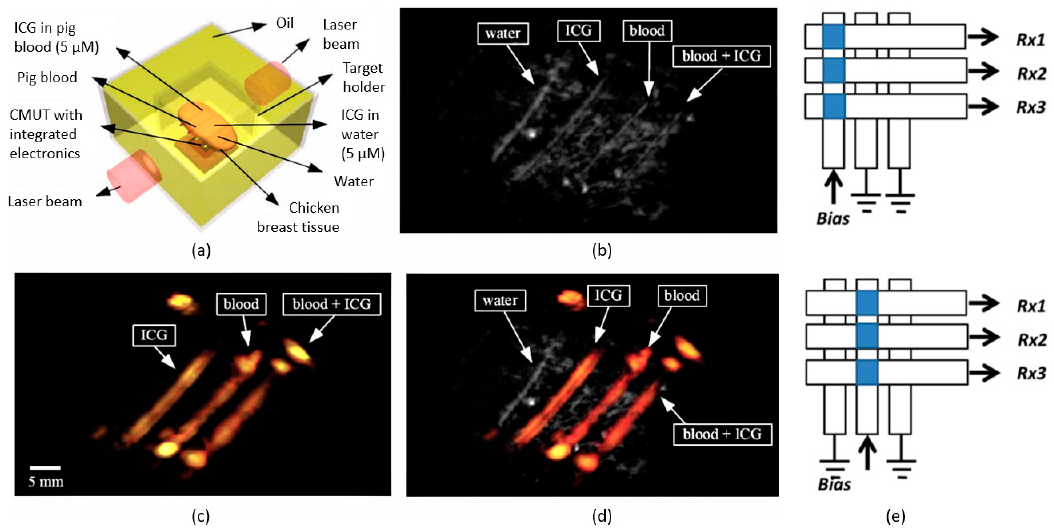
Figure 3. ( a ) Model of the chicken breast phantom, ( b ) ultrasonic imaging, ( c ) PAI, and ( d ) a combination of photoacoustic and ultrasonic imaging ( © [2009] IEEE. Reprinted, with permission, from [117]); ( e ) working principle of top orthogonal to bottom electrode (TOBE) ( © [2014] IEEE. Reprinted, with permission, from [124]).